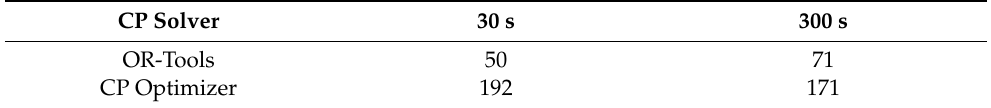
Table 4. Scoring points of CP Optimizer and OR-Tools for JSSP instances.